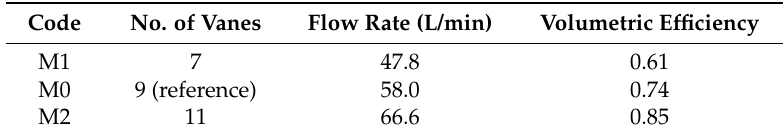
Table 3. Flow rate and volumetric efficiency at 5000 rpm with different numbers of vanes. A code has been associated with each configuration.